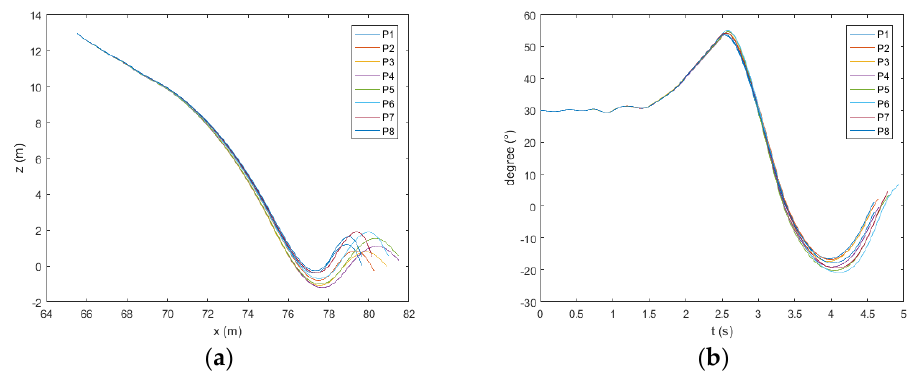
Figure 19. Trajectory ( a ) and pitch ( b ) of the lifeboat freefall when the wave height is 1 m.